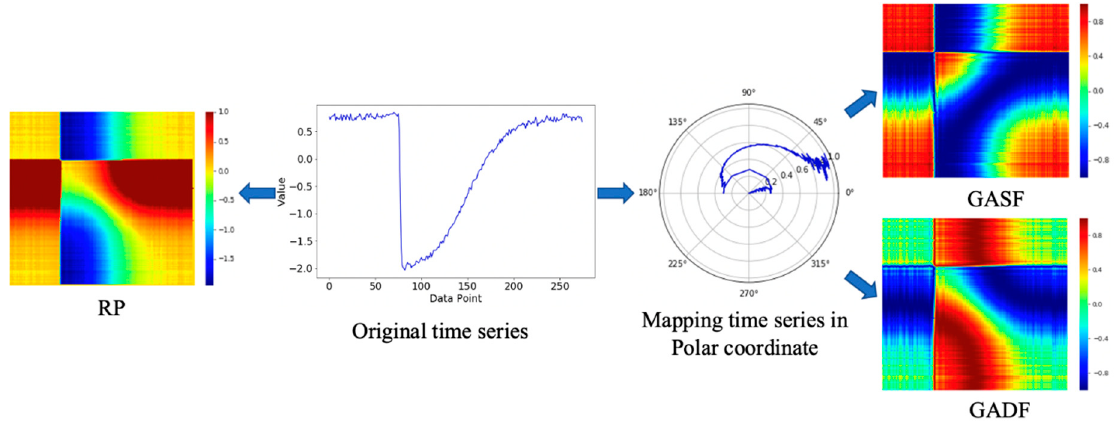
Figure 2. The conversion of a time series using RP and GAF methods.